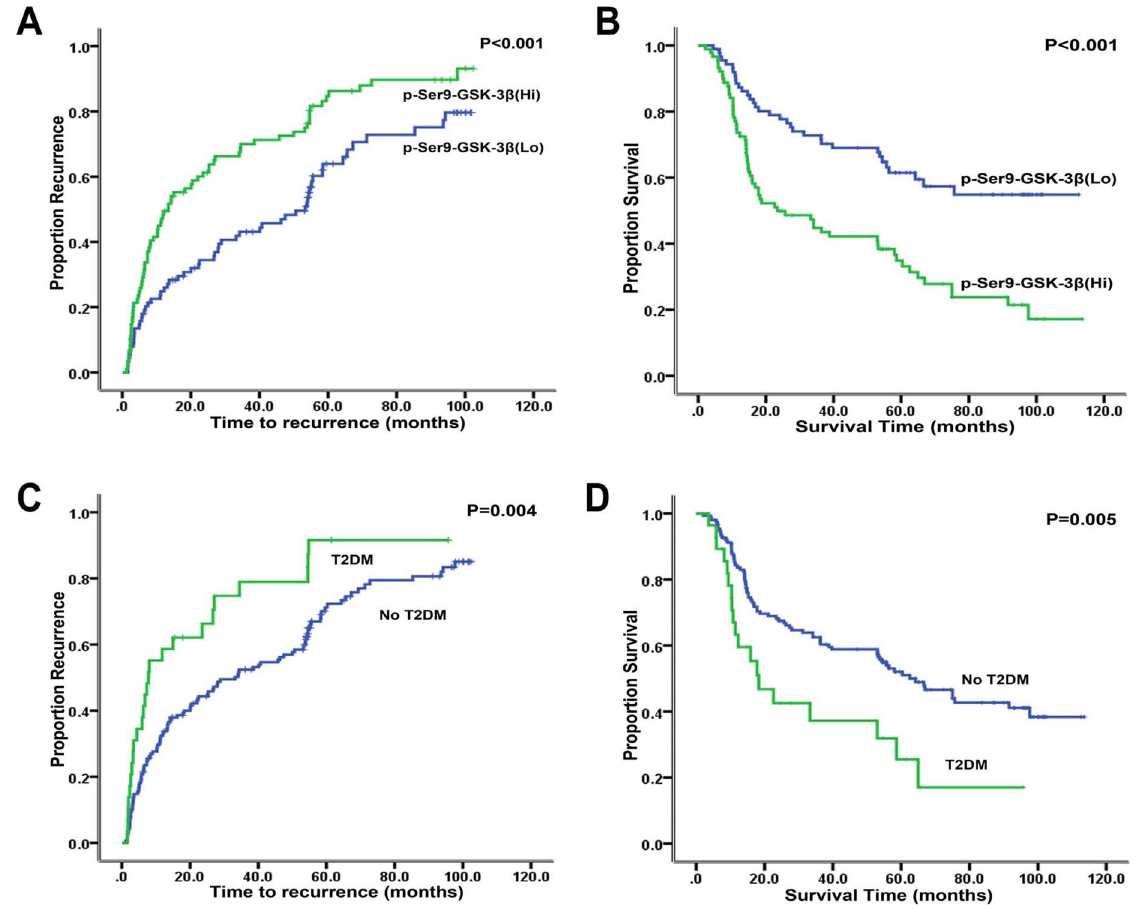
Figure 3. Kaplan-Meier analysis of TTR and OS of patients with HCC. (A,B) Kaplan-Meier curves of the correlation between p-Ser9-GSK-3 b expression level and (A) recurrence or (B) overall survival of HCC patients; (C,D) Kaplan-Meier curves of the correlation between T2DM and (A) recurrence or (B) overall survival of HCC patients.